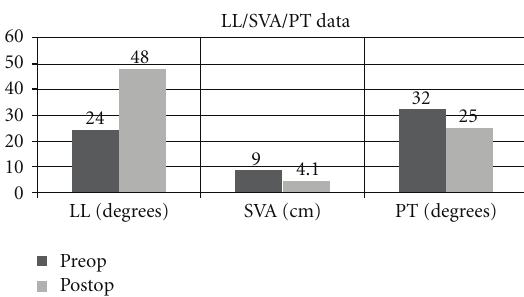
Figure 4: Graph demonstrating pre- and postoperative values for lumbar lordosis (LL), sagittal vertical axis (SVA), and pelvic tilt (PT) in our cohort.